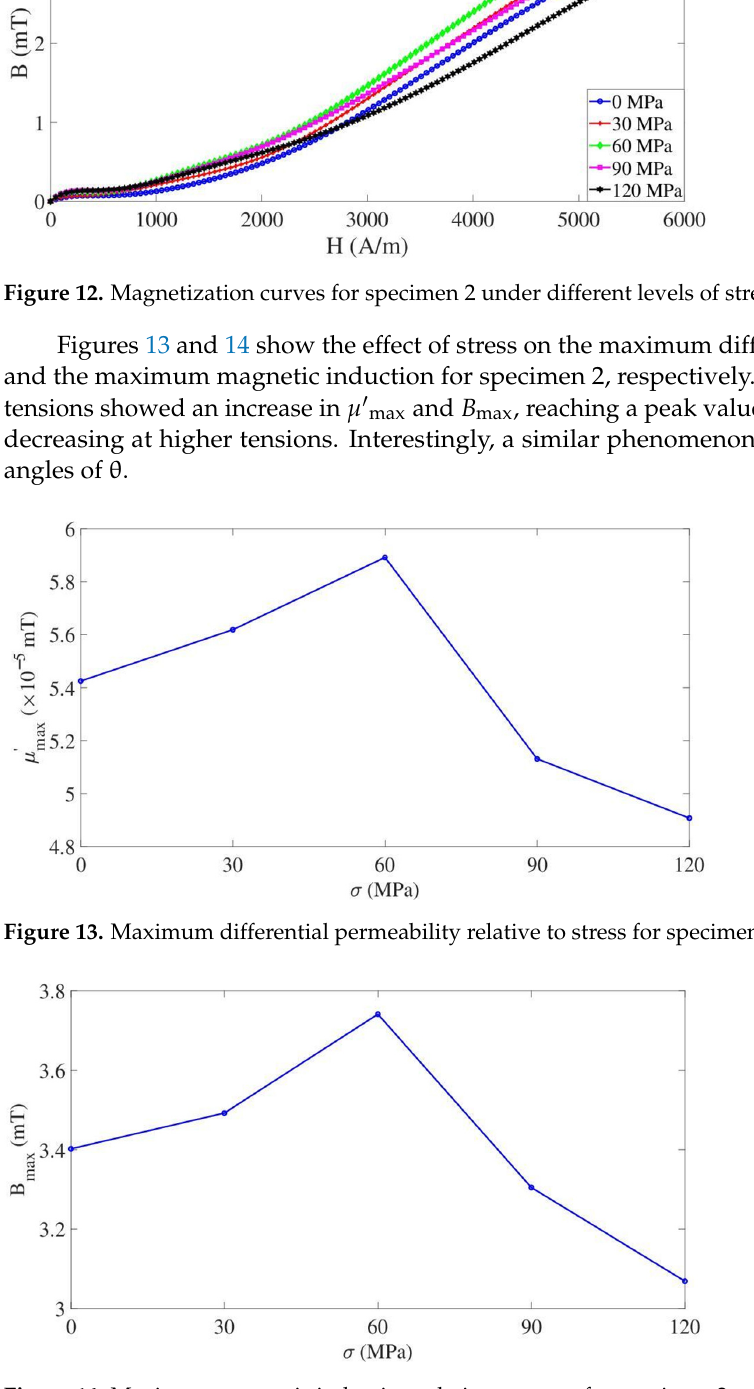
( b ) Figure 15. Error bars of magnetization measurements for specimens ( a ) at different angles, ( b ) at different levels of stress. 4. Discussion First, as shown in the experiment results in Figure 8, the resulting magnetic induction B was not parallel to the magnetic field H at different angles, it rotated slightly with the increase in θ . This phenomenon could be attributed to the stress making the steel anisotropic. It is well known that, for isotropic steel, B is parallel to H. Magnetic anisotropy in the sample would cause a shift in the direction of the surface magnetization. According to Jiles’ model [26], the effects of uniaxial stress on magnetization can be described in terms of an effective field due to the stress, that is